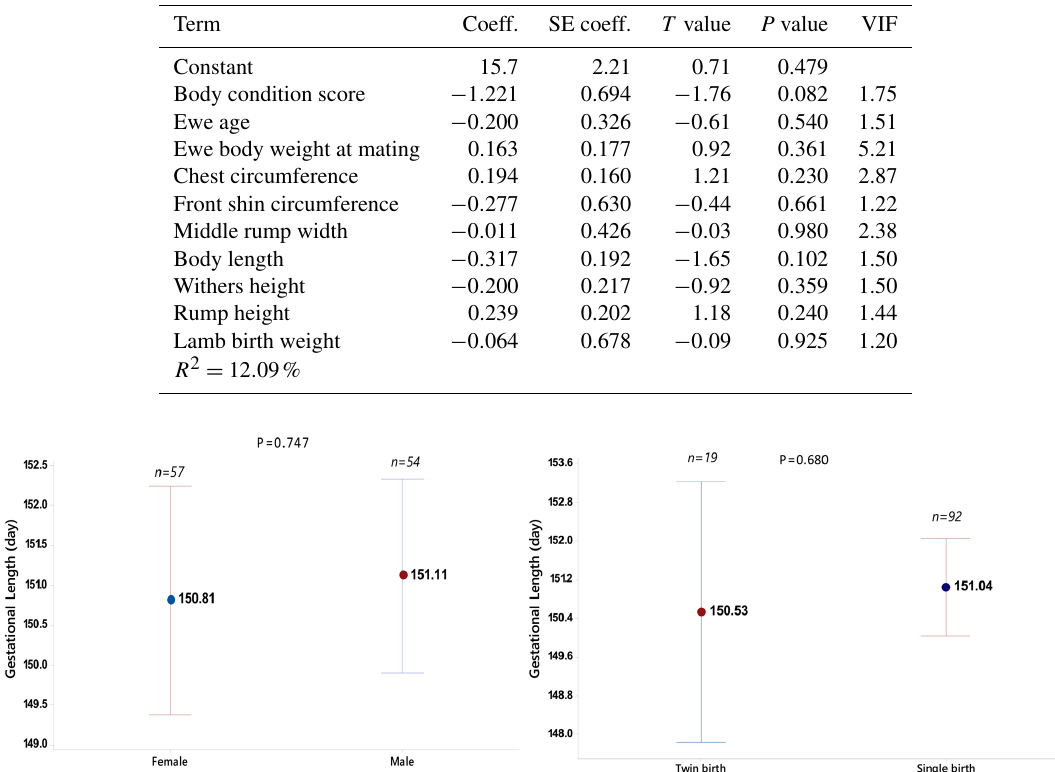
Figure 1. Interval plot showing the confidence interval of the gestational length for sheep with respect to the sex and birth type.